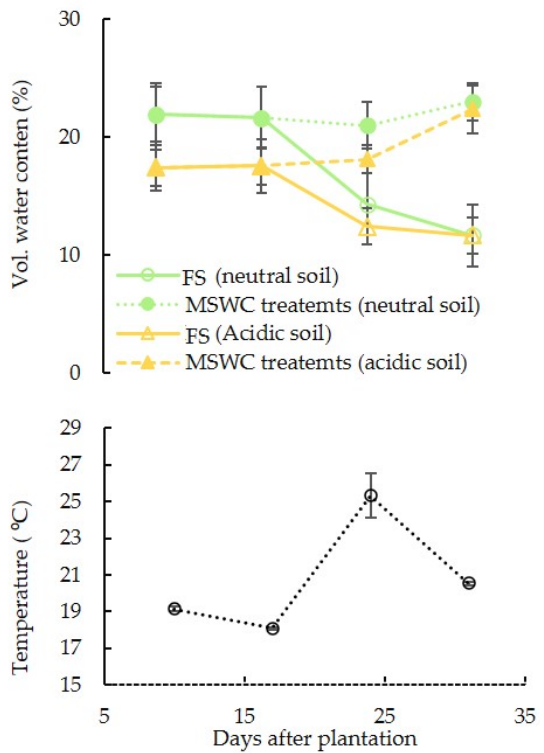
Figure 2. Effects of soil and MSWC supplemented or not with inorganic nitrogen on soil volumetric water content (%) values at 0–5 cm depth and soil temperature at 10 cm depth. Each symbol represents the mean of six replicates, while the error bars represent ±1 standard error.